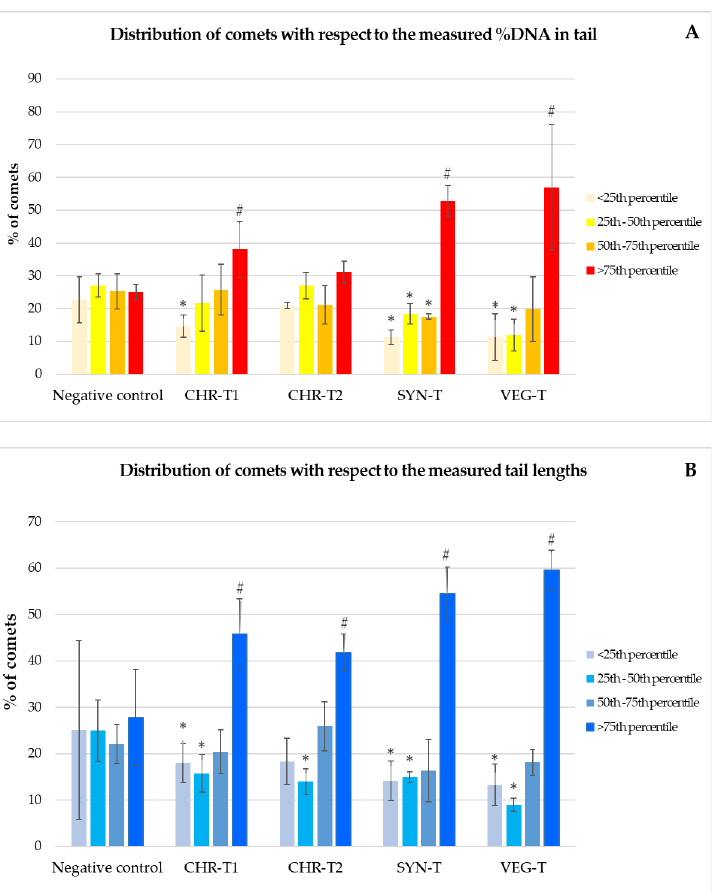
Figure 3. Frequency distribution of DNA damage ( A and B ) in HepG2 cells after 24 h exposure to the tested leather samples and the corresponding negative control. CHR-T1 and CHR-T2 correspond to the leather sample processed with two chrome tanning procedures; SYN-T corresponds to the leather sample processed with synthetic tanning; VEG-T corresponds to the leather sample processed with vegetable tanning. Results are reported as mean ± standard deviations of three independent evaluations that each separately included measurement of 100 comets. * — significantly decreased ( p < 0.05) vs. negative control; # — significantly increased ( p < 0.05) vs. negative control (Pearson ’ s χ 2 test).